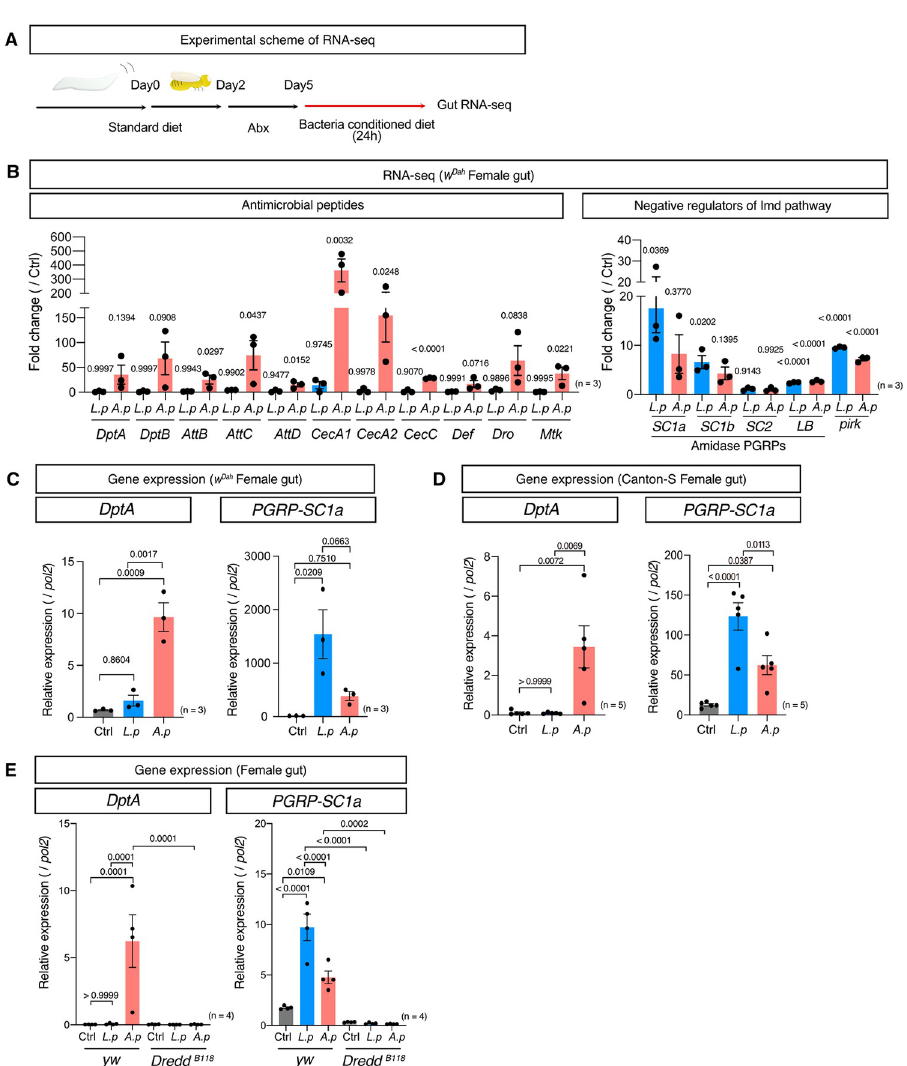
Fig 3. Transcriptional regulation of distinct Imd target genes by bacterial species. (A) The experimental overview of RNA-seq analysis of female w Dah gut after 24 hours of BacD. (B) RNA-seq read count data of antimicrobial peptide (AMP) genes and Imd negative regulator genes in w Dah female fly guts after 24 hours of BacD shown in fold change. For the statistics, ANOVA with Holm-Sˇı ´ da ´ k’s multiple comparison was used. (C)(D) Quantitative RT–PCR of DptA and PGRP-SC1a in w Dah (C) and Canton-S (D) female fly guts after 24 hours of BacD. For the statistics, ANOVA with Holm-Sˇı´da´k’s multiple comparison was used. (E) Quantitative RT–PCR of DptA and PGRP-SC1a in yw and yw- backcrossed Dredd B118 female fly guts after 24 hours of BacD. For the statistics, ANOVA with Holm-Sˇı´da´k’s multiple comparison was used. The control diet followed the same procedure for BacD but it has only MRS broth in place of bacterial isolates, resulting in the antibiotics-contained diet. Sample sizes (n) and P values are in each figure.